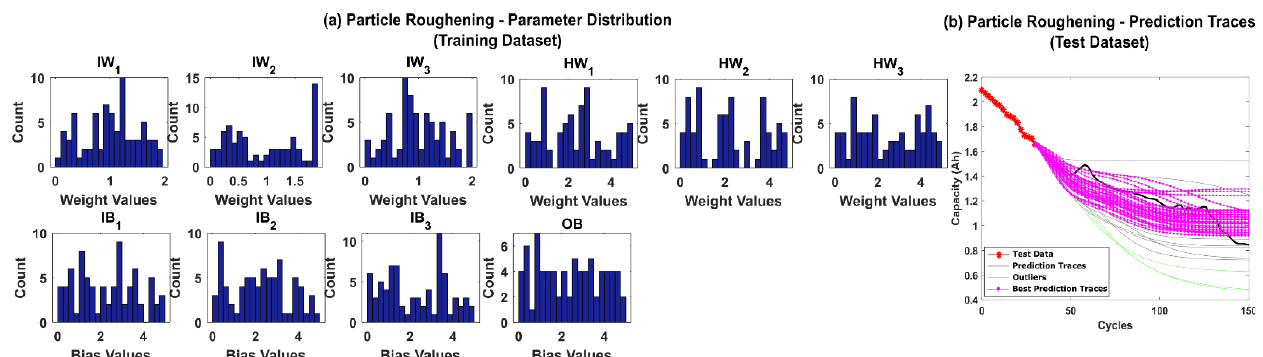
Figure 14. ( a ) The posterior distribution of MLP network parameters estimated by the adaptive Bayesian learning framework using particle roughening and ( b ) the degradation prediction traces for NASA battery (RW-11) using particle roughening. The prediction traces for 50 repetitions are shown using the gray lines, the green lines represent outliers, and the magenta lines represent the traces with minimum RMSE values.